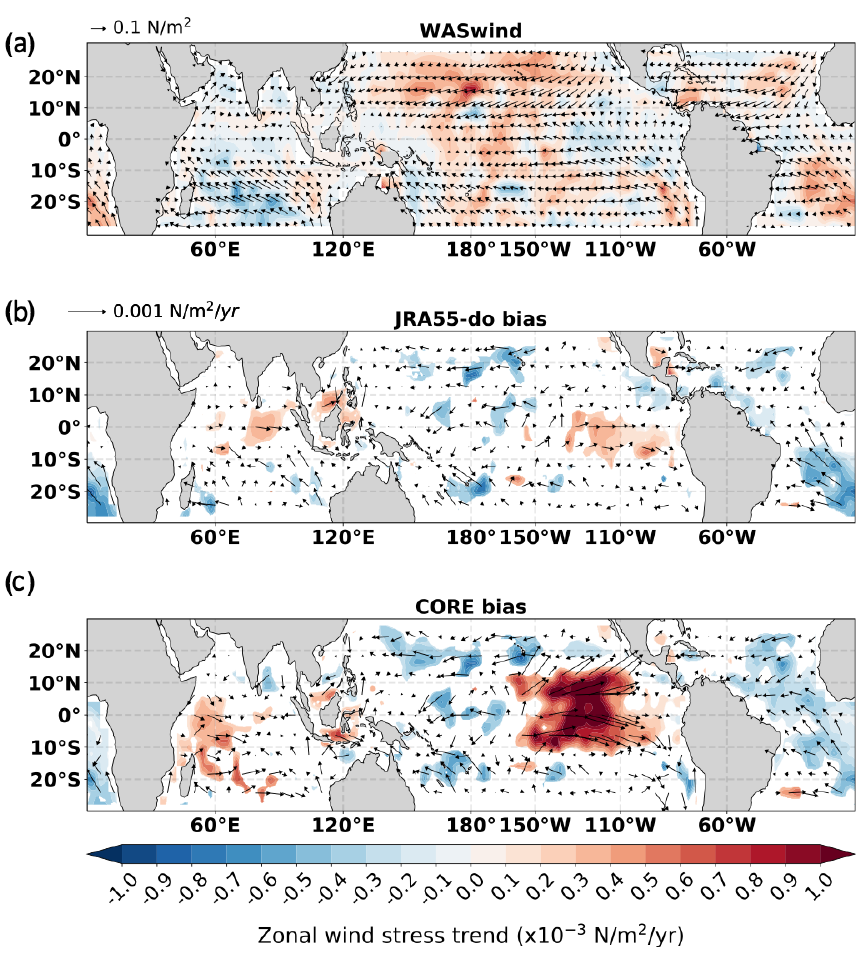
Figure 11. (a) The zonal wind stress trend (shading) and mean state of wind stress (arrow) during 1958–2007 in the observational data (WASwind). (b) The zonal wind stress trend bias (shading) and wind stress trend bias (arrow) over the same period in JRA55-do forcing data. The same as panel (b) but with (c) CORE forcing data. The shading in panels (b, c) shows the trend is statistically significant with 99%